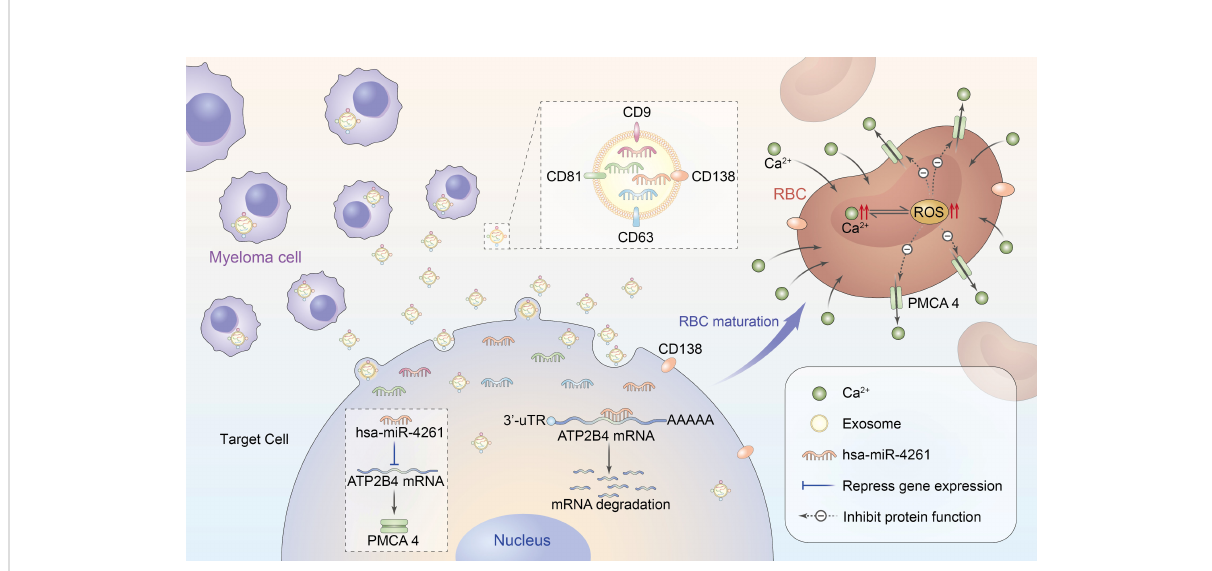
FIGURE 8 Schematic diagram of RBC calcium overload mediated by MM exosomal miR-4261. Exosomes secreted by MM cells transfer miR-4261 to erythroid precursor cells, resulting in RBC calcium overload by downregulating the expression of ATP2B4. Calcium overload can cause crosstalk that leads to an increase in intracellular ROS levels, forming a vicious cycle that causes further damage to the activity of PMCA4 in